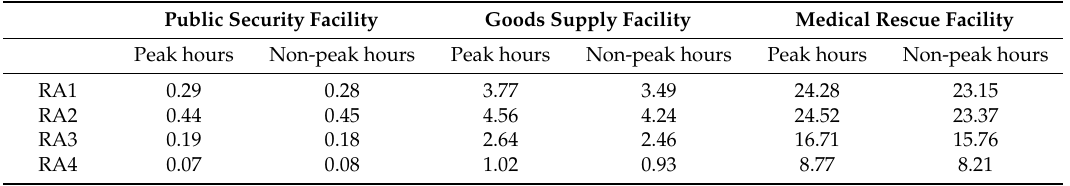
Table 4. Rescue Supply-Demand Index (RSDI) of Each Type of Rescue Facility.